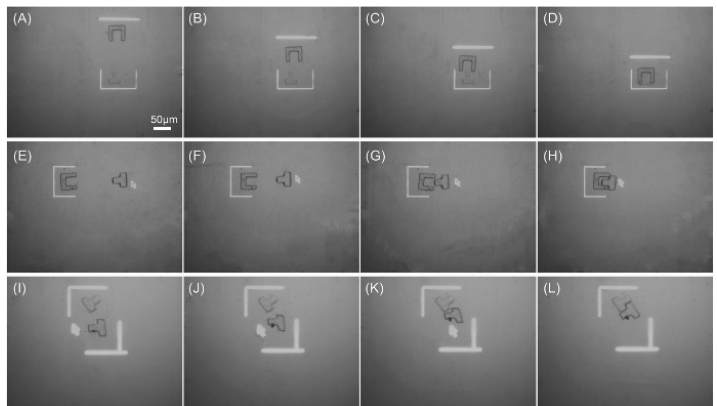
Figure 16. ( A – G ) Captured microscope image showing the dynamic process of assembling ( A – G ) Captured microscope image showing the dynamic process of assembling microstructures with different sizes and shapes; ( H – L ) the experimental process of assembling two microstructures with di ff erent sizes and shapes; ( H – L ) the experimental process of assembling two different microstructures (reproduced from Ref. [83]). di ff erent microstructures (reproduced from Ref. [83]).